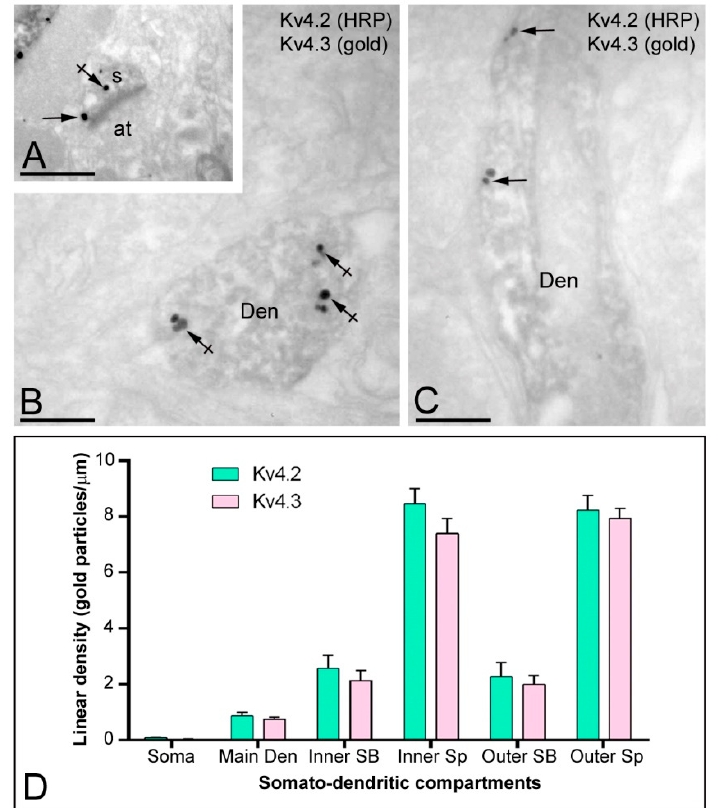
Figure 9. Co-localisation of Kv4.2 and Kv4.3 in granule cells. ( A – C ) Electron micrographs showing co-localisation for Kv4.2 with Kv4.3, as detected using a double-labelling pre-embedding immunogold method at P60. Labelling is shown with immunoperoxidase reaction for Kv4.2, and with silver-intensified immunogold reaction for Kv4.3. Immunoparticles for Kv4.3 were seen in dendritic spines (s) and shafts (Den) of granule cells immunopositive for Kv4.2, both along the plasma membrane (arrows) and at intracellular sites (crossed arrows); ( D ) Change in the density of Kv4.2 and Kv4.3 in DG granule cells as a function of distance from the soma in six somato-dendritic domains. Density of immunoparticles for the two channel subtypes increased significantly from soma to dendritic spines (Sp) in the inner one-third and outer two-thirds of the molecular layer. This analysis demonstrated their similar non-uniform distributions over the neuronal surface of granule cells. Inner SB, spiny branchlets in the inner one-third; Outer SB, spiny branchlets in the outer two-third; Inner Sp, spines in the inner one-third; Outer Sp, spines in the outer two-third. Scale bars: A – C , 500 nm.